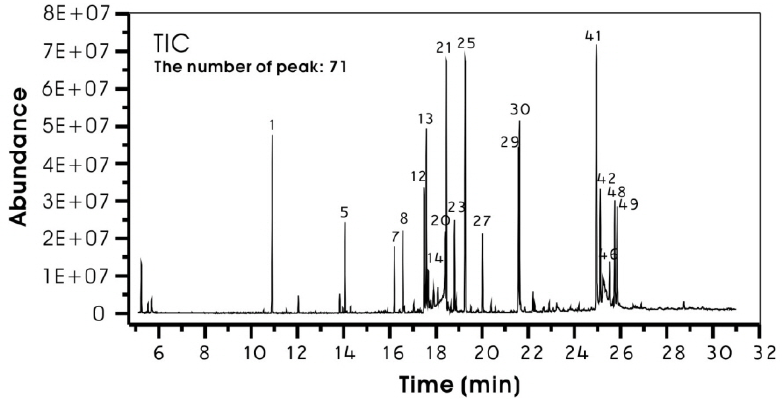
Figure 1. Total ion chromatogram (TIC) of derivertised methanol extract of Dryopteris crassirhizoma by GC-MS. Major components were marked on the plot with their peak numbers, which were connected with their chemical names in Table